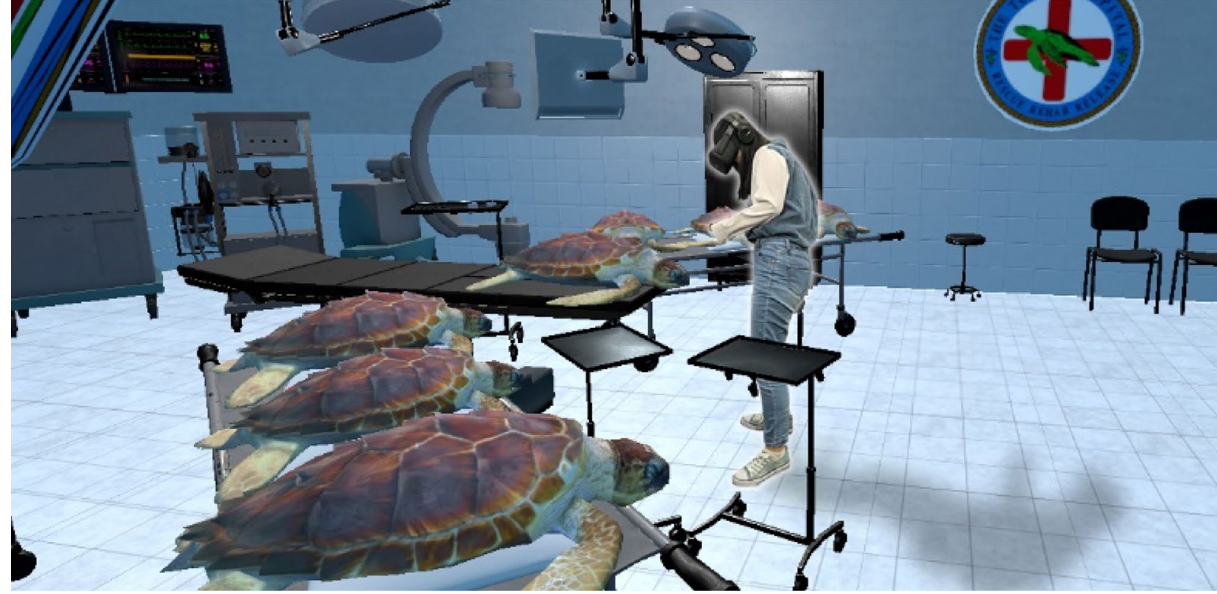
Figure 1. Visual representation of the Study 1 stimuli. A participant in the seven victims condition (left) inspects the virtual Loggerhead